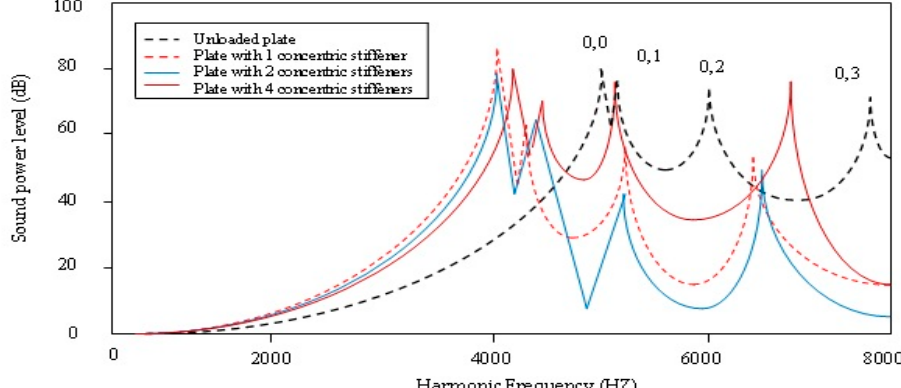
Figure 19. Numerical comparison of sound power level for annular plate having parabolic decreasing thickness variations (Case I) for different combinations of concentric stiffener patches for taper ratio T x = 0.75.